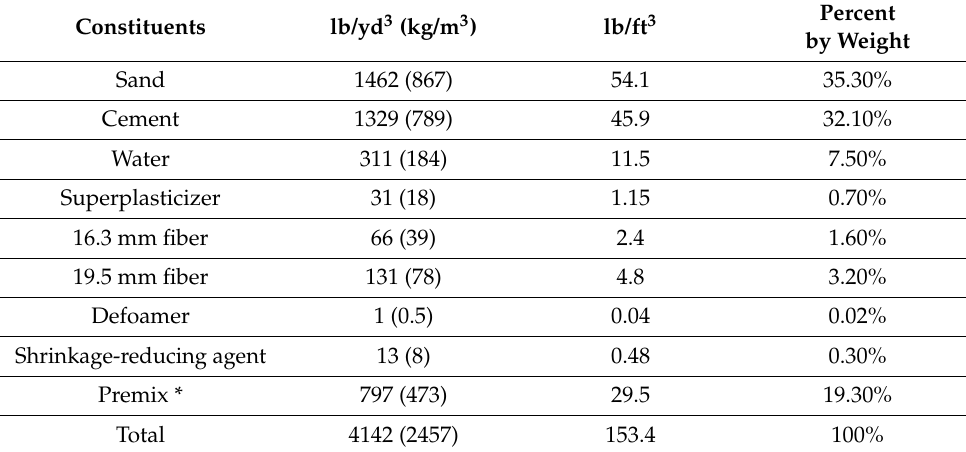
Table 1. Mix design of UHPC.